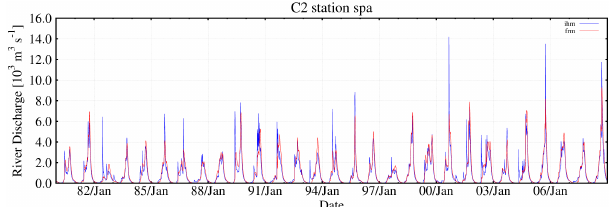
Figure 7. Comparison of time series of river discharge between the FRM (red line) and IHM (blue